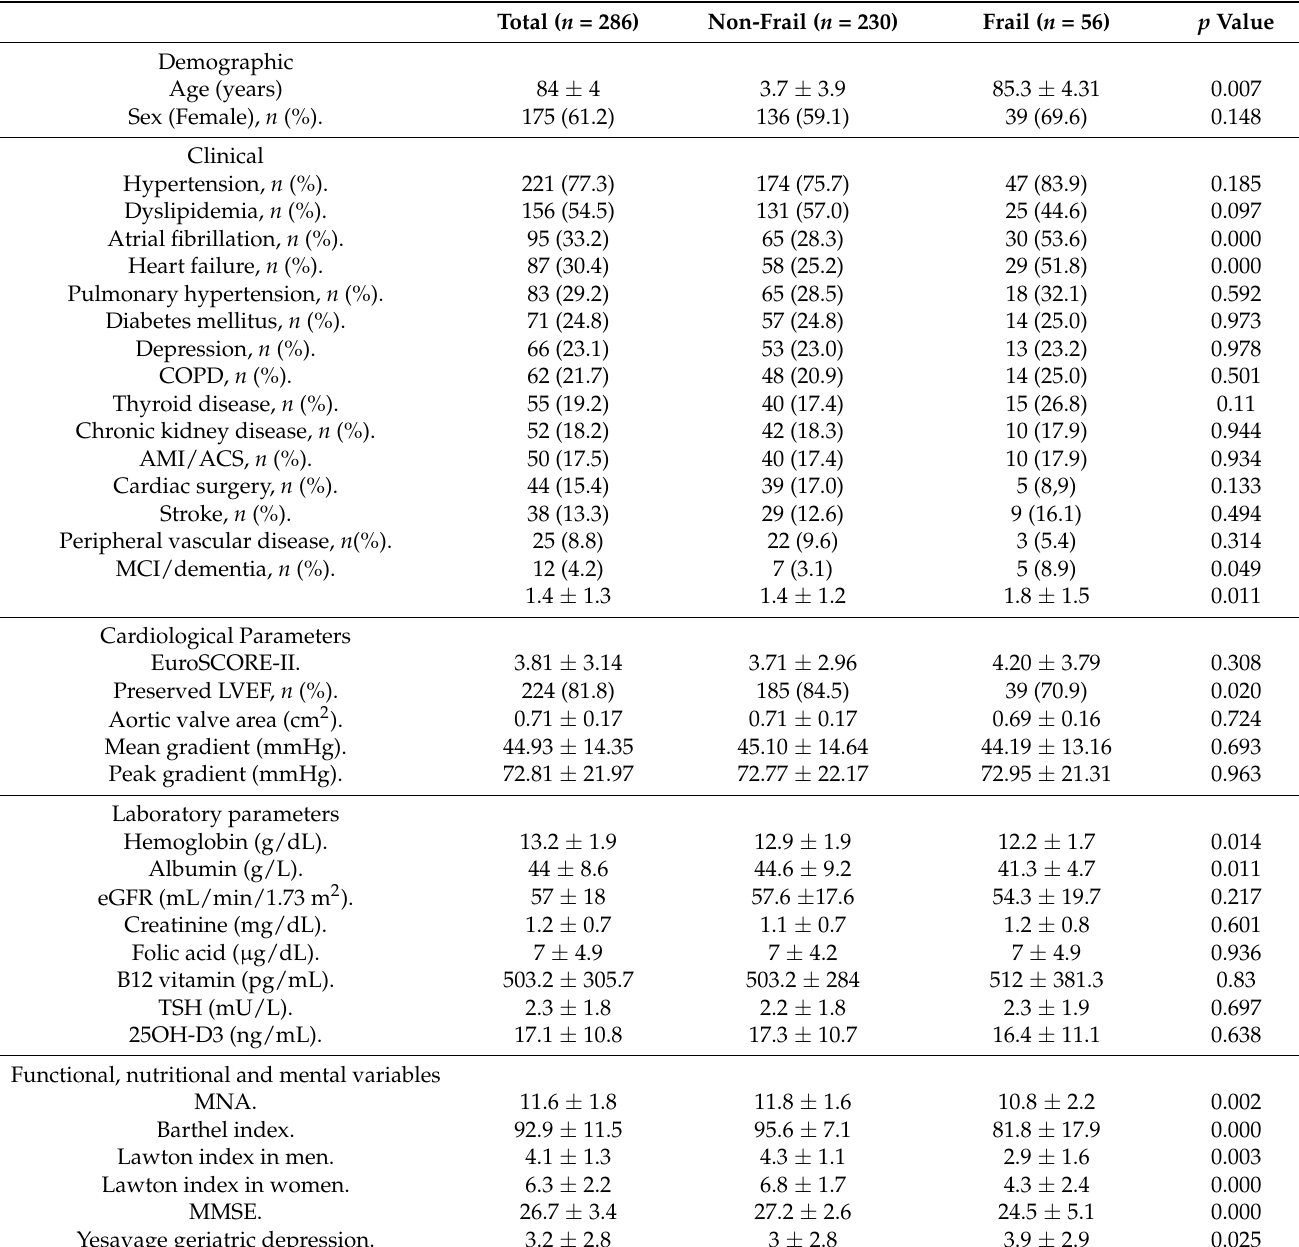
Table 1. Baseline characteristics of the patients included in the